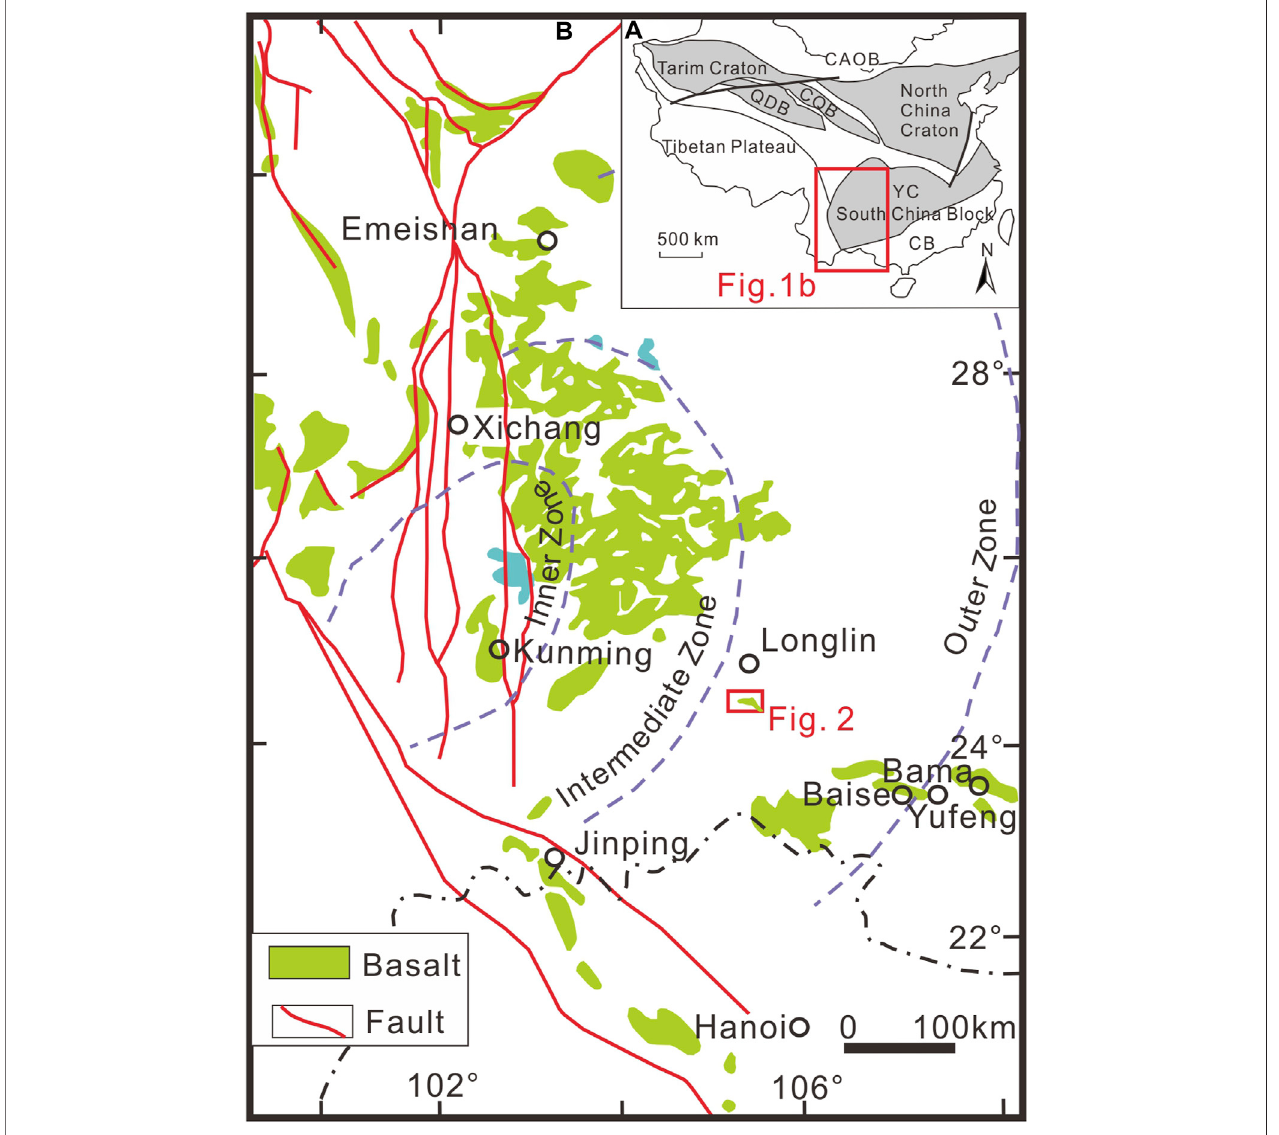
FIGURE 1 | Spatial distribution pattern of the Permian Emeishan fl ood basalts (outermost purple line denotes the possible extent of the outer zone, after Xu et al., 2001; He et al., 2003). YC – Yangtze Craton; CB – Cathaysia Block; CQB – Central Qilian Block; QDB – Qaidam Block; CAOB – Central Asian Orogenic Belt.